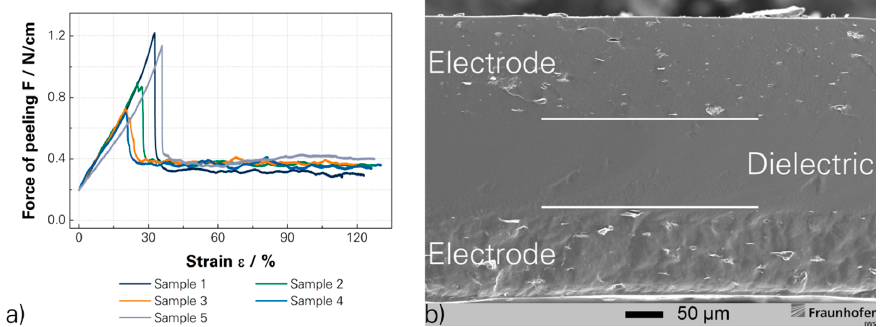
Figure 6. ( a ) Mechanical testing of the peeling force [15]; and ( b ) a cryogenic-fractured SEM image of a three layer DEA